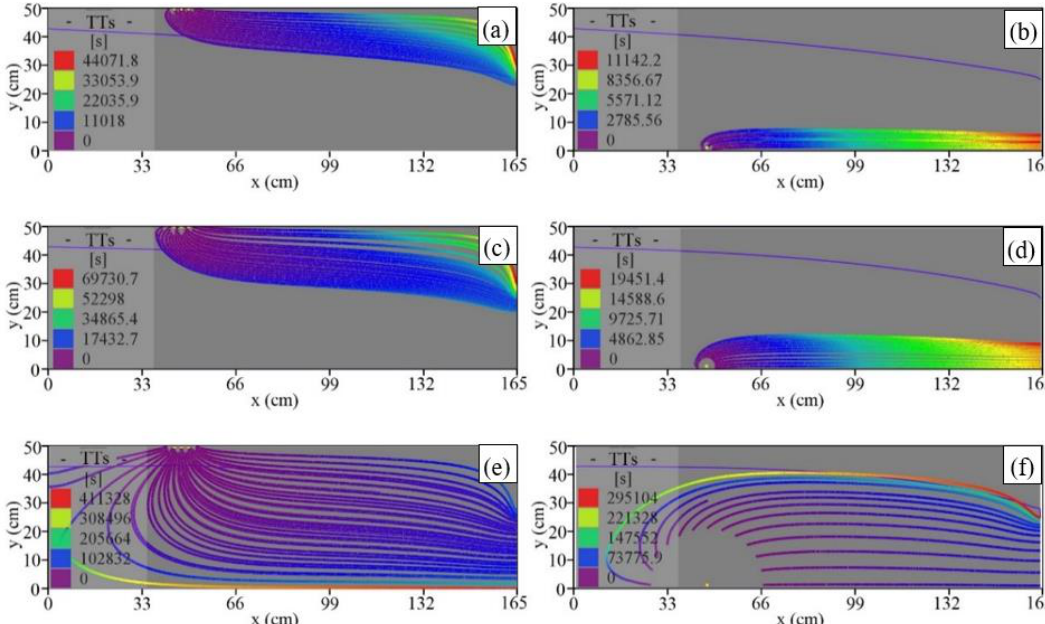
Figure 17. Artificially recharged water lens associated with travel times (TTs) produced by the infiltration basin (left panel of the figures) and injection well IW1 (right panel of the figures) with different length-decay exponents. The length-decay exponents in ( a ) and ( b ) were set to 0.005 m −1 . The length-decay exponents in ( c ) and ( d ) were set to 0.01 m −1 . The length-decay exponents in ( e ) and ( f ) were set to 0.02 m −1 . The blue lines in the figures represent the water table. The yellow points in the figures are the locations of injection wells. The rainbow lines are flow paths of artificially recharged water.